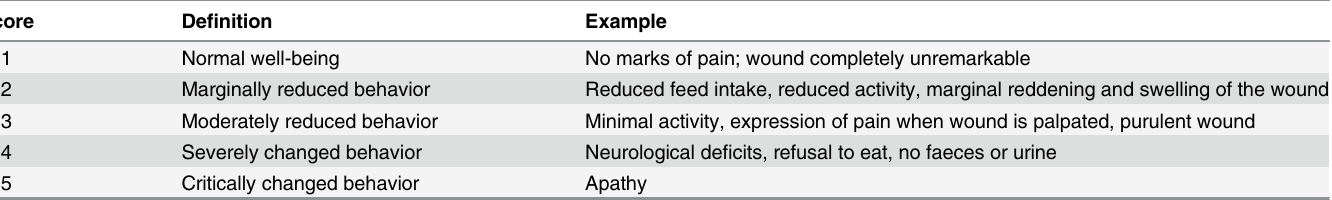
Table 1. Animal Health Score.